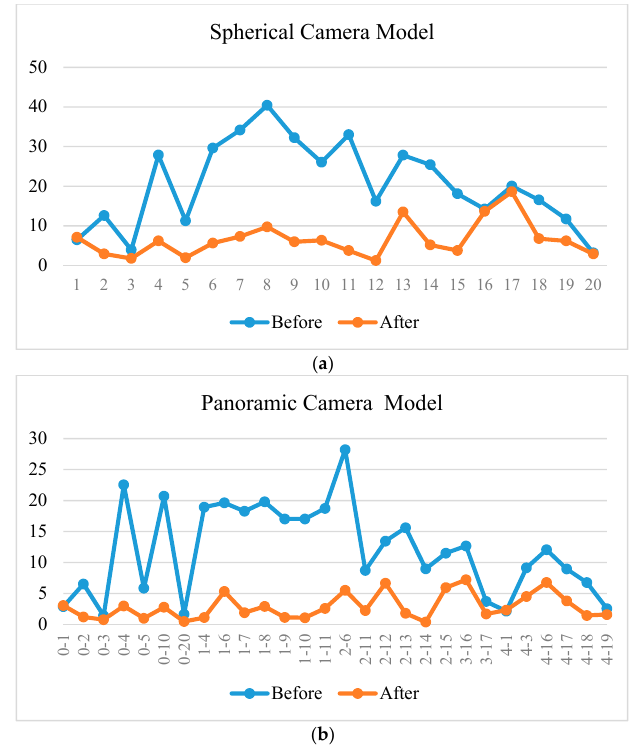
Figure 13. The residuals of the check points before and after registration based on the panoramic camera model . The vertical axis is the residual in pixels; the horizontal axis is ( a ) the ID of the check points and ( b ) the ID of the lens and check points (lens ID—check point ID).